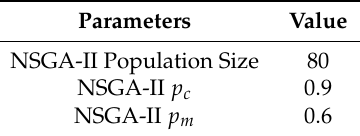
Table 4. NSGA-II setup